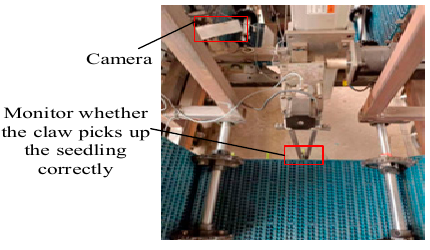
Figure 4. Monitor transplanting status.